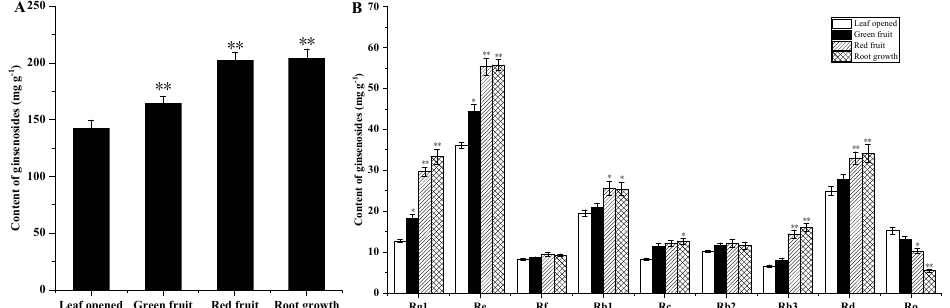
Figure 3. Ginsenoside contents of stems from Panax ginseng during the different growth stages. The total ginsenoside content in the stem ( A ) and the major individual ginsenosides in the stem ( B ) were analyzed according to the leaf opened, green fruit, red fruit, and root growth stages. Vertical bars indicate the mean ± standard error from three independent experiments. The data are expressed as the mean ± SD. * indicated that the different growth stages are significantly different at the 0.05 level. ** indicated that the different growth stages are significantly different at the 0.01 level.